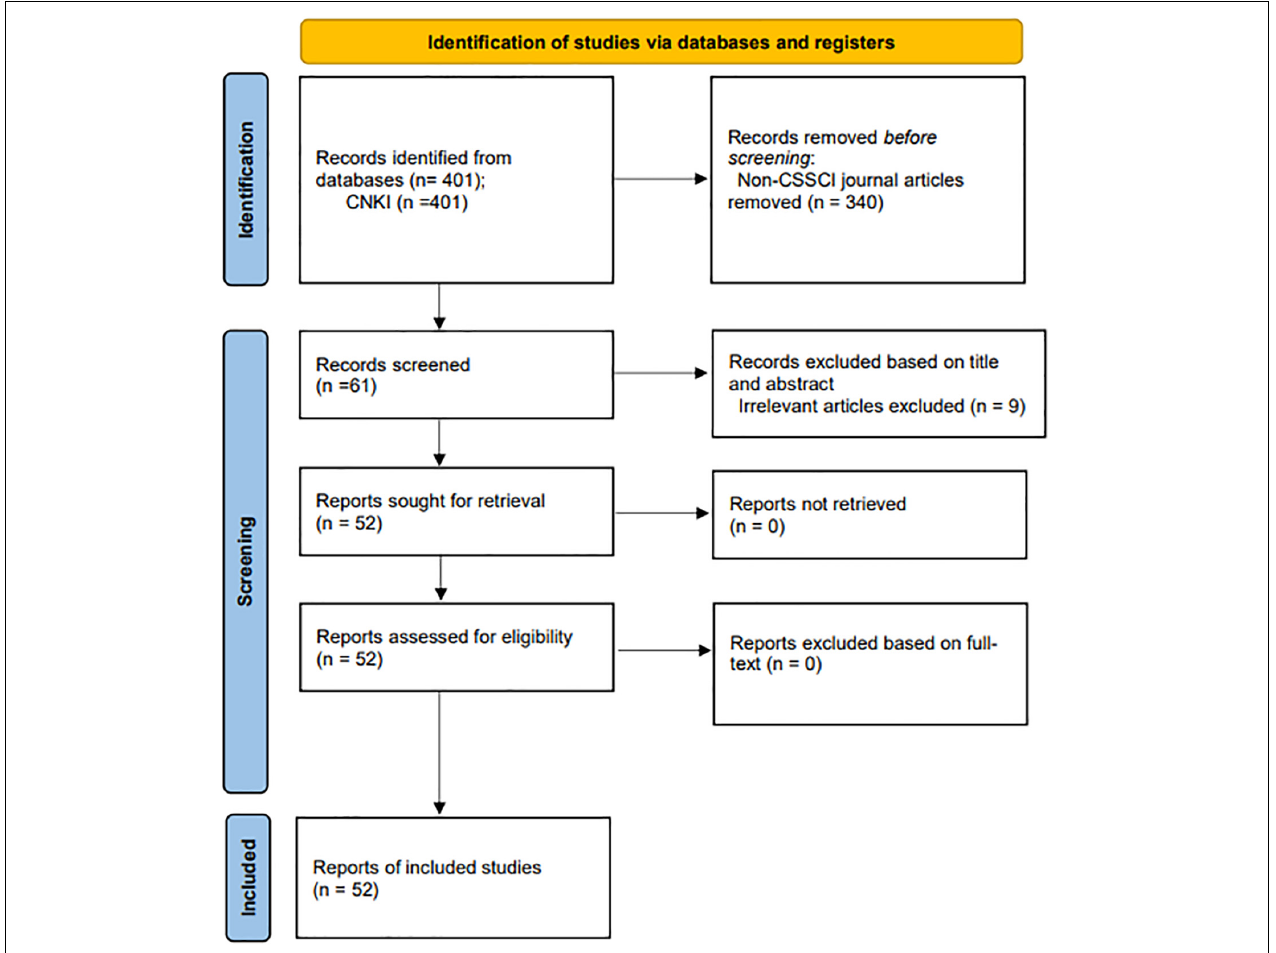
FIGURE 1 | Chinese language articles’ selection